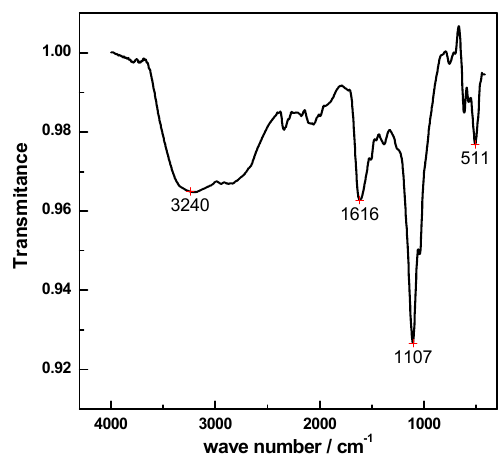
Figure 5. FTIR spectrum of the deposited MnO x ‐ LS film.